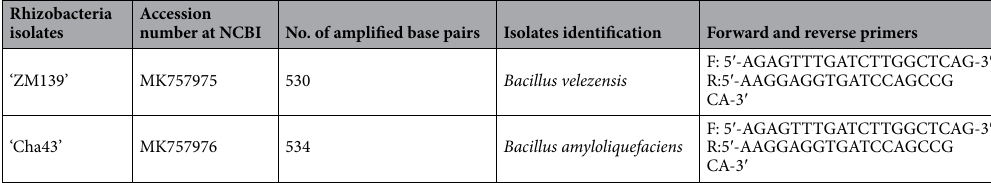
Table 4. Molecular characterization of two selected rhizobacteria isolates based on16s rDNA